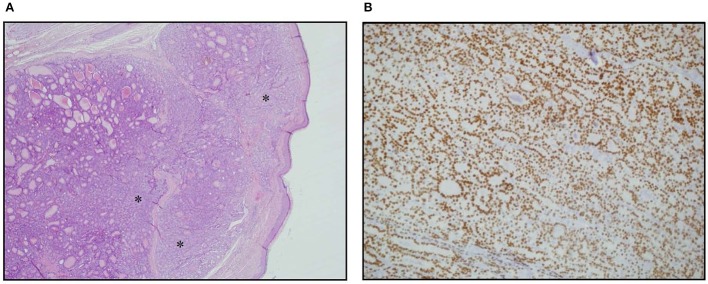
Skin metastasis. (A) Hematoxylin Eosin staining of histological slides, magnification 4 × 1. *indicates less differentiated areas. (B) Immunohistochemical staining of TTF-1, magnification 20 × 1.